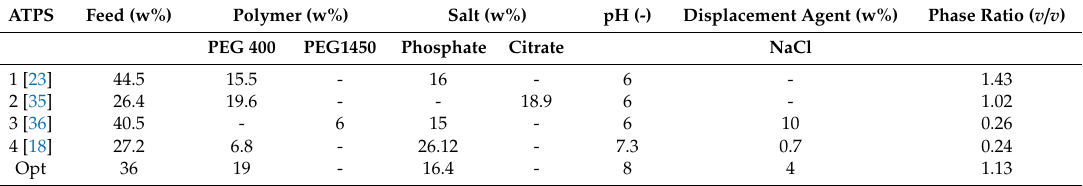
Table 1. ATPS composition and the respective phase ratios. ATPS: aqueous two-phase